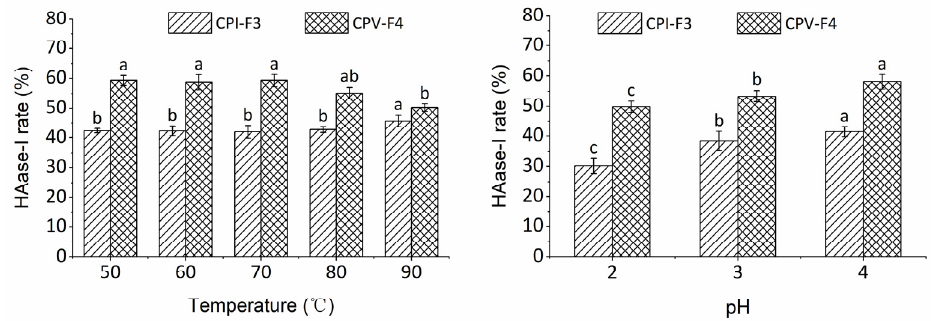
Figure 5. The stability of CPI-F3 and CPV-F4 under different treatments of temperature and pH. Different superscripts of the same sample note the significant differences ( p < 0.05). All results are mean ± SD from three determinations.